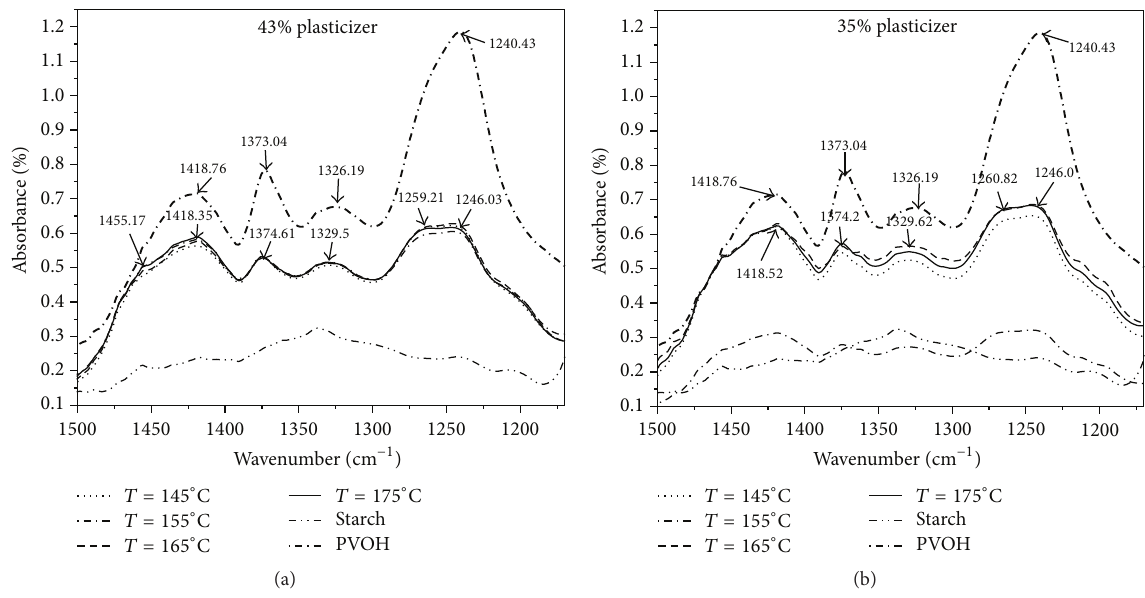
Figure 7: The dependence of the ATR absorption in the range of 1500 cm −1 to 1120 cm −1 on the plasticizing level ((a) 43%; (b) 35%) and the extrusion temperature (10kg load).